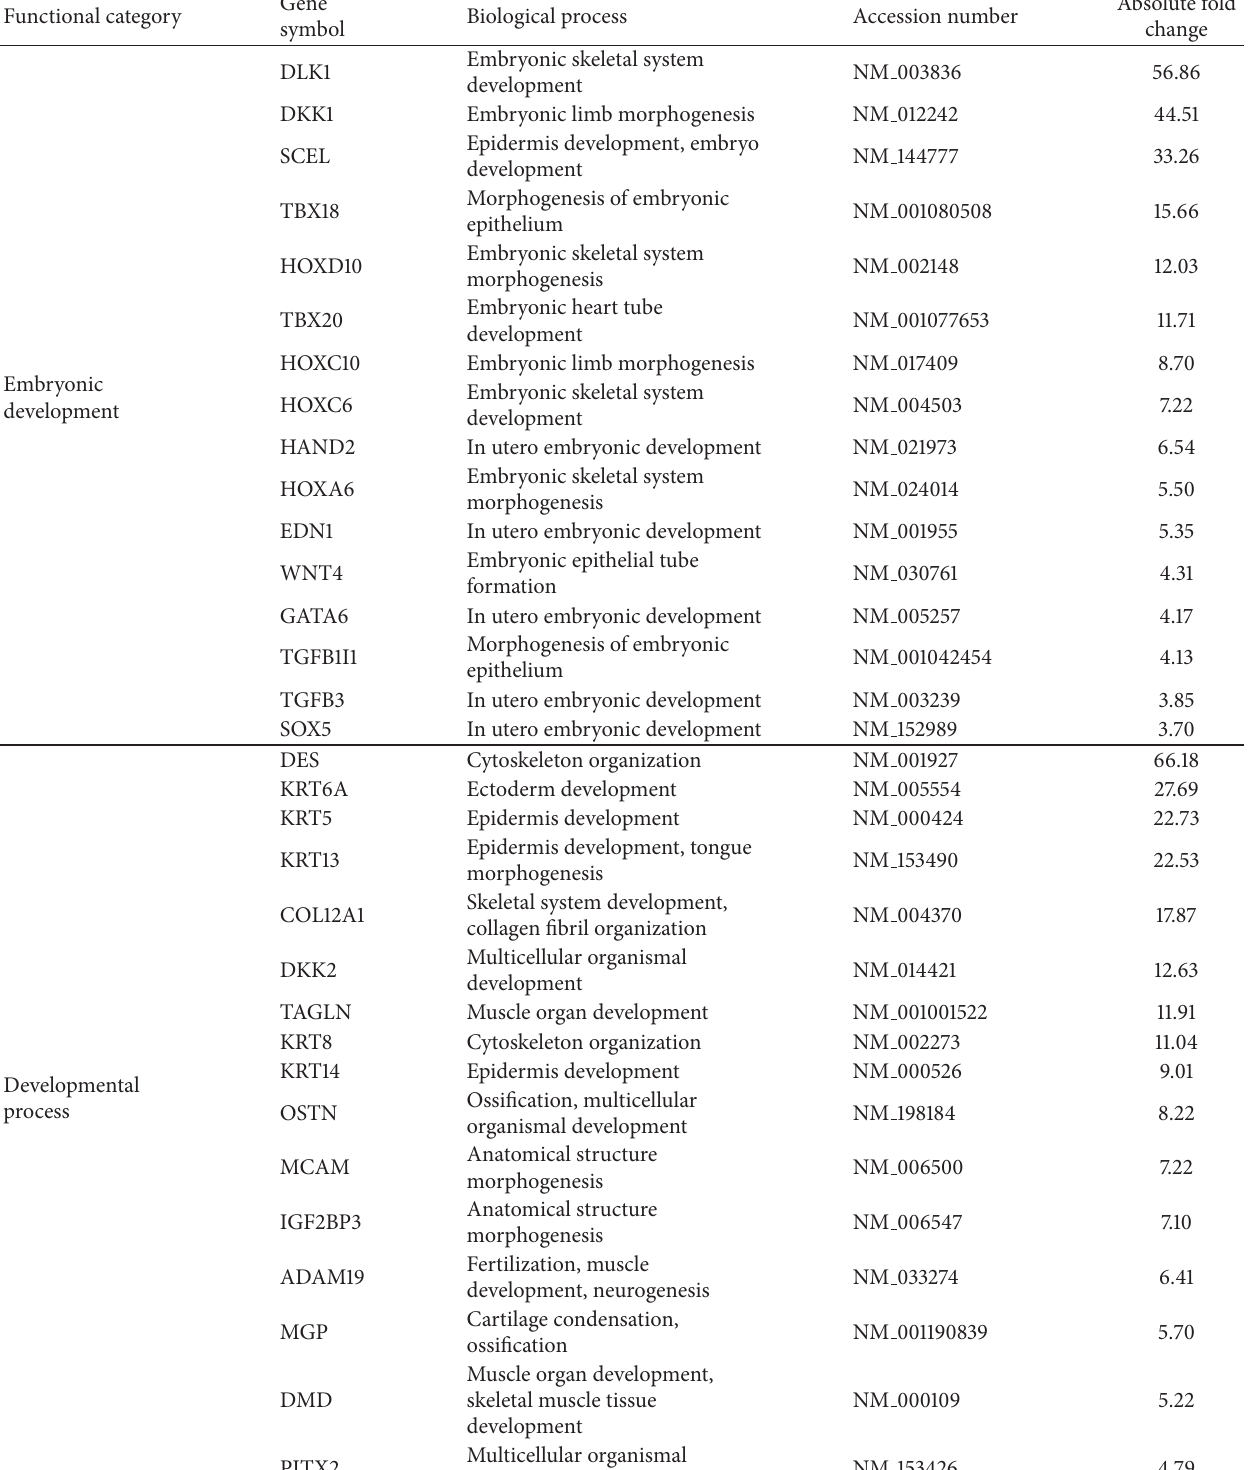
Table 2: Representative differentially expressed genes with higher expression levels in umbilical cord than in dental pulp tissue. Functional